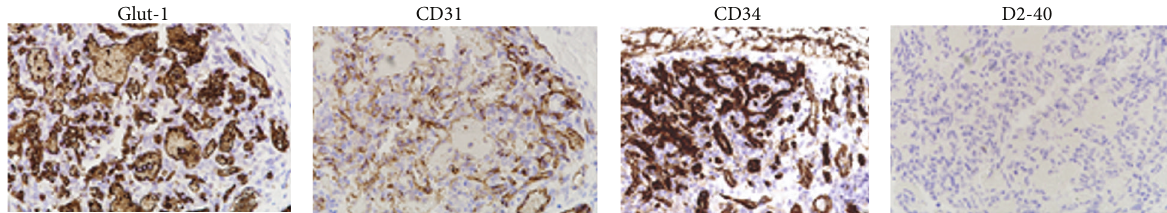
Figure 4: The endothelial cells are positive for Glut-1 which favors hemangioma rather than vascular malformation. They are also positive for CD31 and CD34 (vascular markers). They are negative for D2-40 stain which rules out lymphangioma. The overall feature is